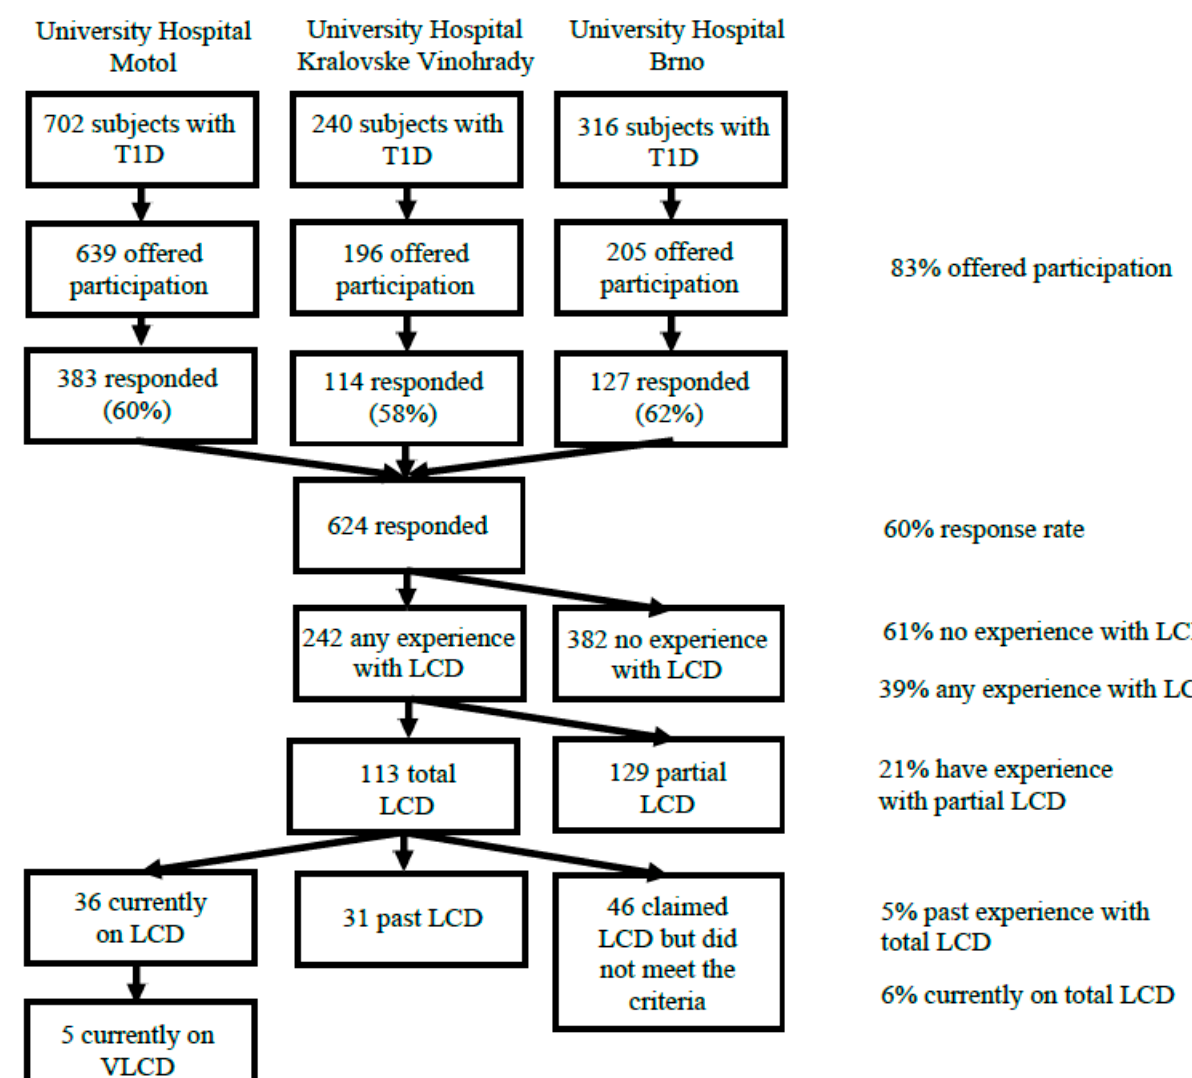
Figure 1. The study flowchart. LCD – low-carbohydrate diet, T1D – type 1 diabetes, VLCD – very low-carbohydrate diet